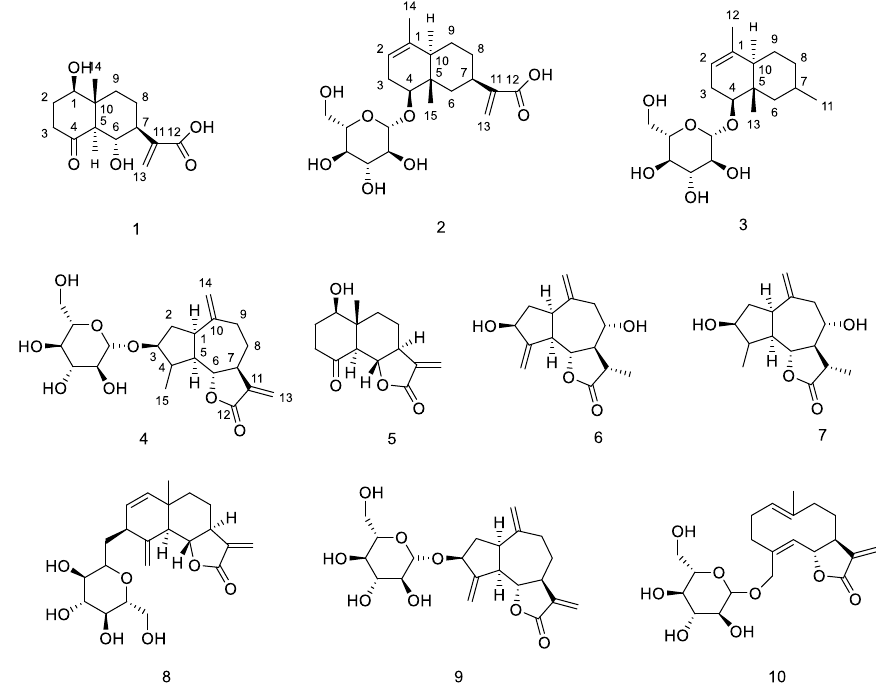
Figure 1. Chemical structures of Compounds 1 – 10 .